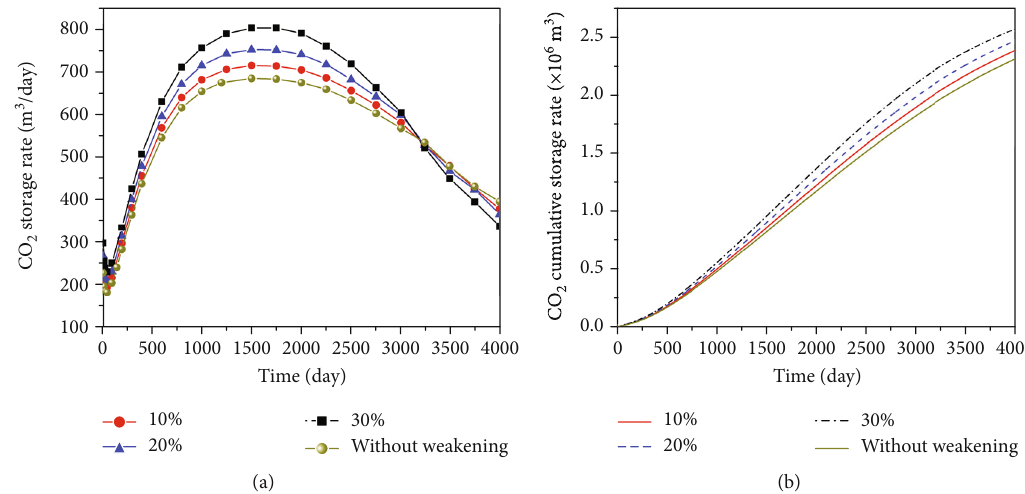
Figure 19: CO storage rate and cumulative storage under di ff erent weakening degrees. (a) CO 2